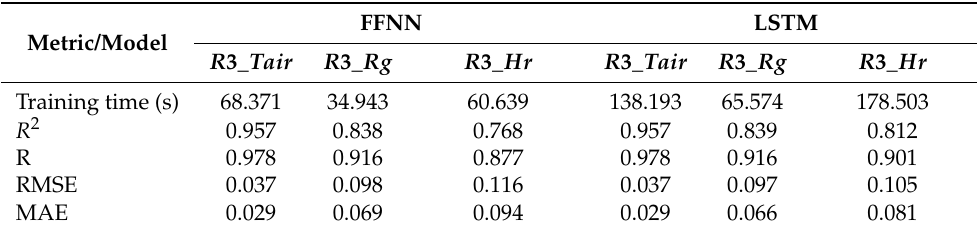
Table 5. Performance of deep learning